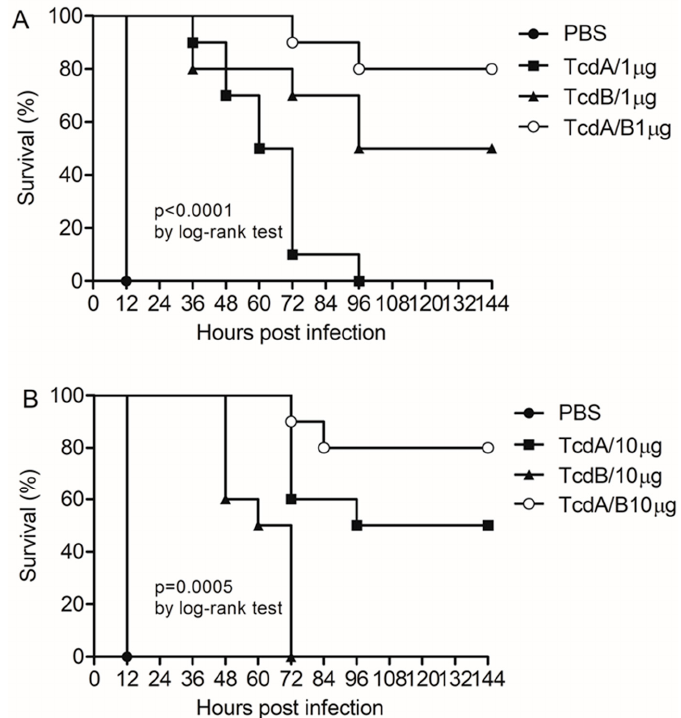
Figure 4. Vaccine candidates protected mice against lethal dose of toxins. ( A ) Survival rates of wild-type C57BL/6 mice immunized with 1 μ g recombinant vaccines and challenged with 1 MLD crude toxins.